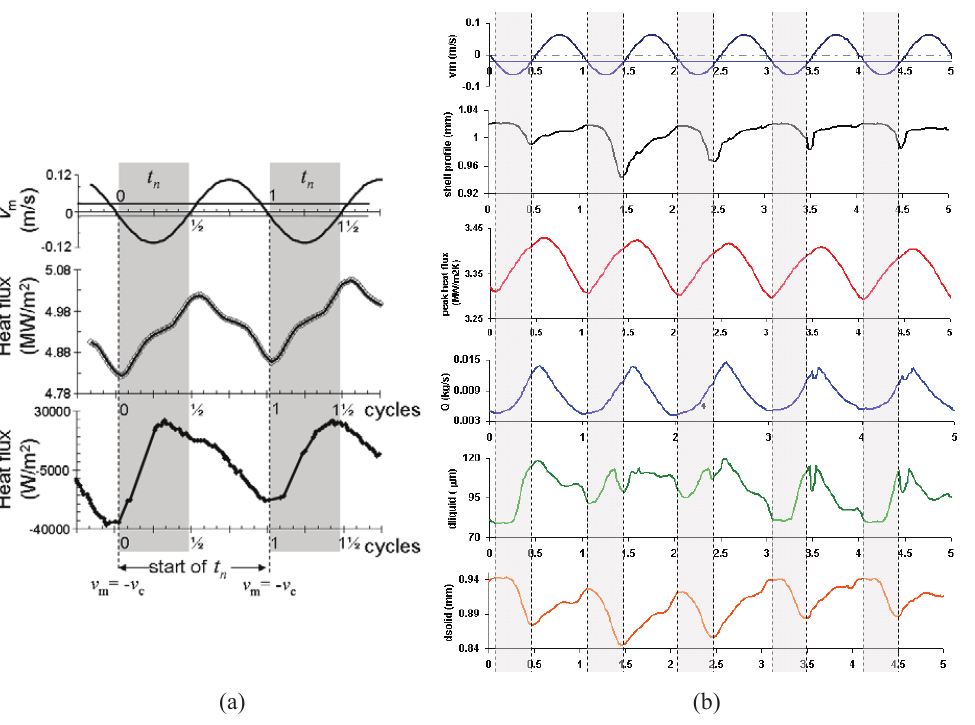
Figure 9. Changes during oscillation cycle (a) (from top) (i) mould velocity ( V m ), (ii) heat flux (model) and (iii) measure- ments due to Badri et al. [15] and (b) (i) mould velocity, (ii) shell profile, (iii) heat flux (iv) powder consumption kgs (cid:3) 1 , (v) thickness of liquid slag film, (vi) thickness of solid slag film; vertical lines denote t n and t p